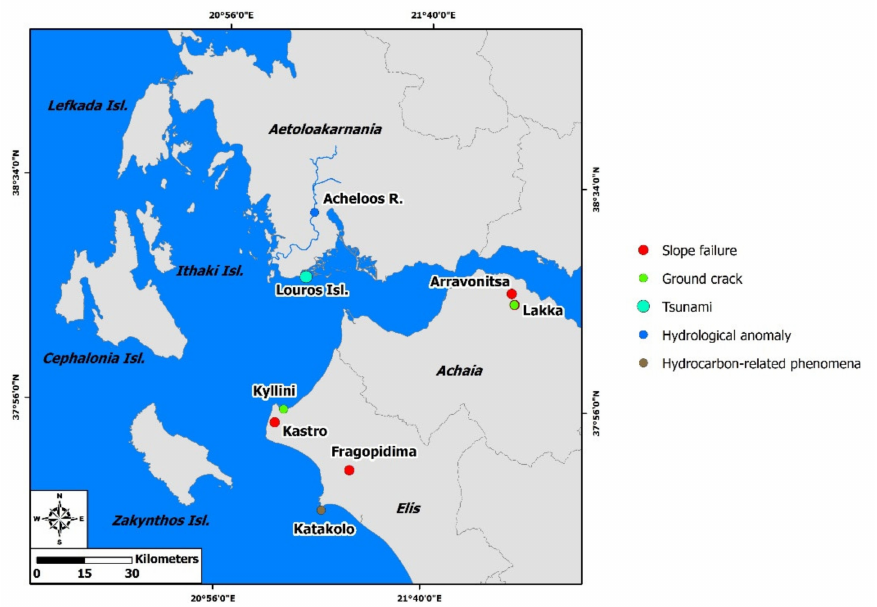
Figure 13. Far field effects induced by the 11 and 12 August 1953